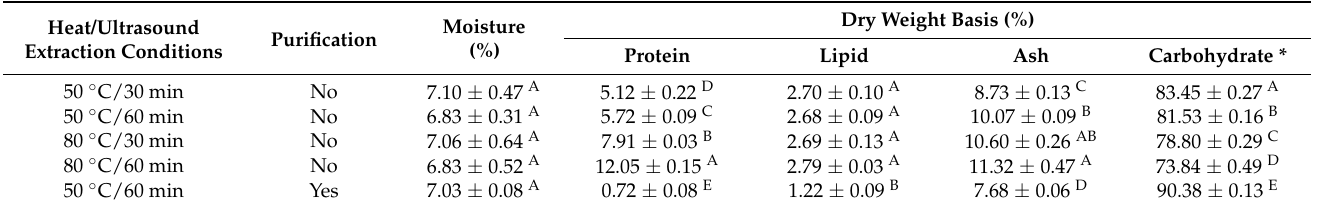
Table 3. The chemical composition of chia seed mucilage powders extracted by ultrasound in combination with heat.